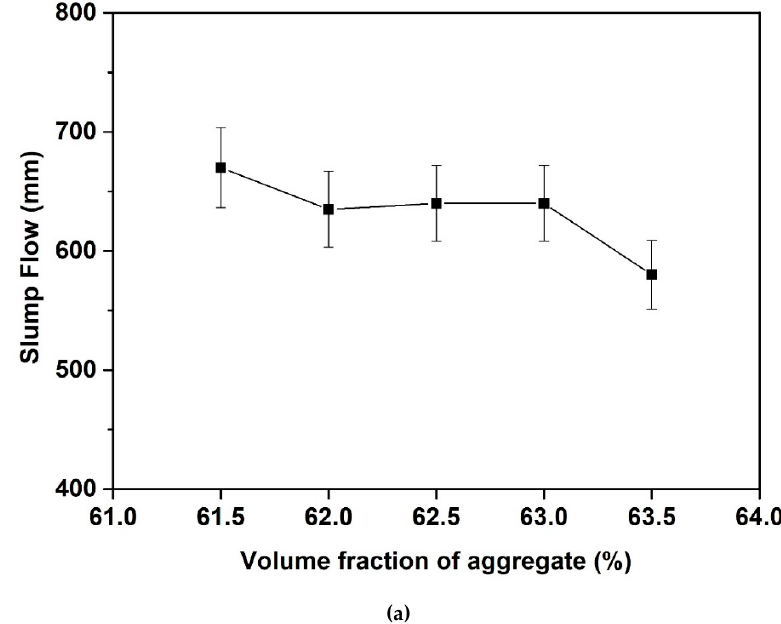
Table 1. Mix proportions of concrete mixtures (kg / m 3 ).